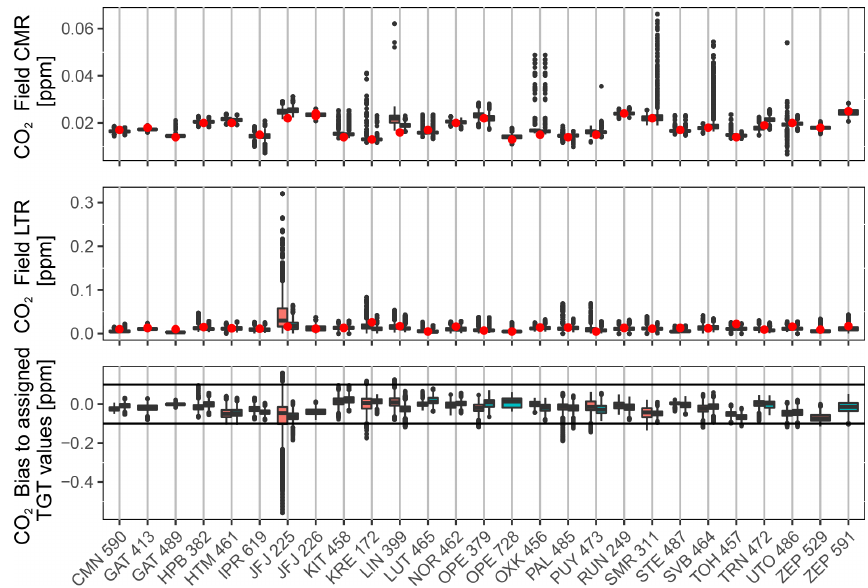
Figure 16. Uncertainties and bias to the short-term target for CO 2 , defined as in Fig. 12. The red dot shows the minute CMR and LTR from the MLab initial tests. The left box (pink) is calculated using data from the year prior to labeling. The right box (blue) is calculated using data from March 2019 to March 2020. For GAT, 489 was prior to 413. For JFJ, 226 replaced 225. At OPE, 729 is running in parallel with 379. At ZEP, 529 was prior to 591. The x axis shows the site trigram and ICOS ID of the analyzer. The black lines in the bias plot show the WMO compatibility goals.